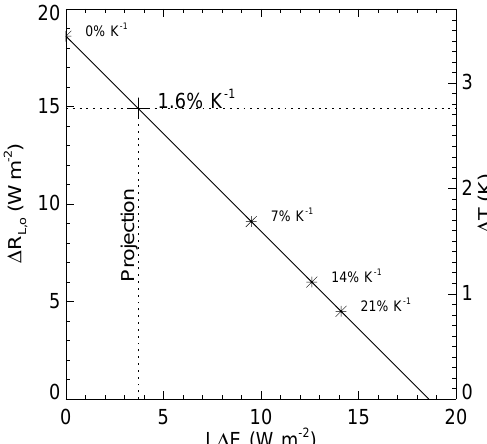
Fig. 6. Relation between global projected change in the la- tent heat flux ( L1E ) and outgoing long-wave irradiance ( 1R L,o ) for a given increase in incoming long-wave irradiance ( 1R L,i ≈ 1R L,o + L1E =18.6Wm − 2 ). Equivalent surface tem- perature changes are noted (right-hand axis) as are the percentage enhancements in global P per